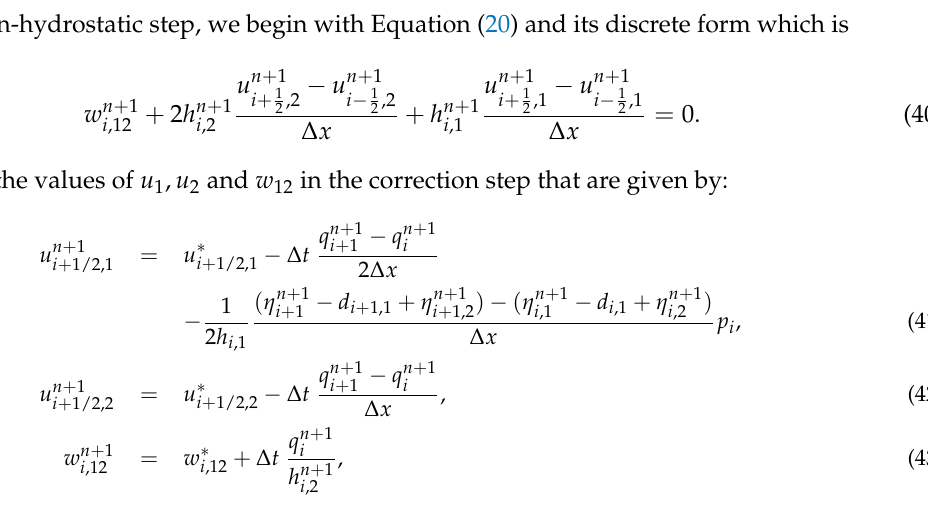
Figure 4. Arrangement of the unknowns in a staggered